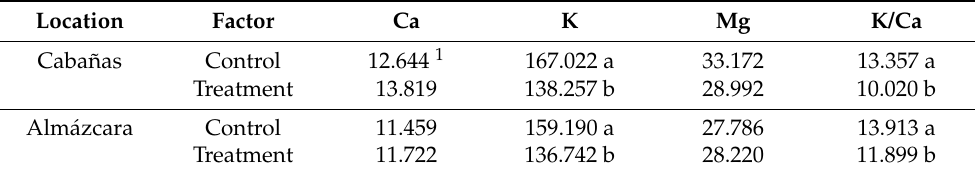
Table 2. Effect of pruning on nutrient concentration (mg per 100g fresh weight) in apple cv. ‘Reinette du Canada’ at harvest.